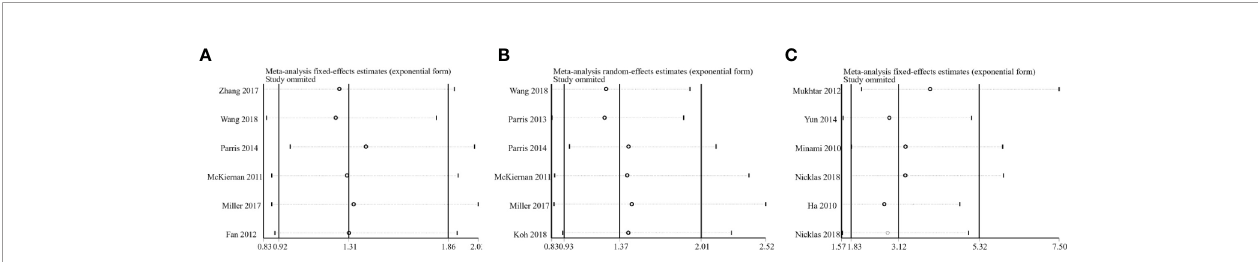
FIGURE 5 | Sensitivity analysis of this meta-analysis. (A) Overall survival (OS). (B) Disease-Free Survival (DFS). (C) Progression-free Survival or Recurrence-Free Survival